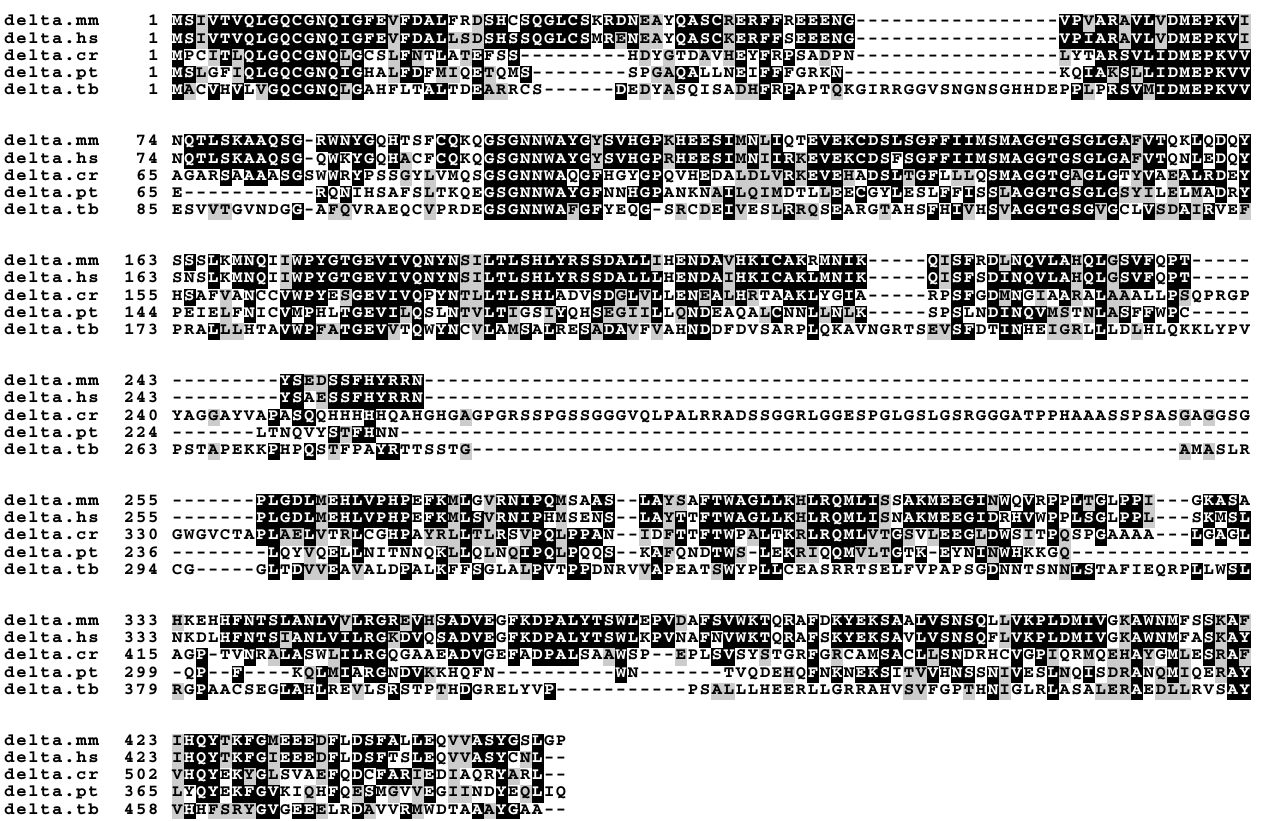
Figure 1 Comparison of the predicted δ PT1 sequence - Paramecium tetraurelia (pt) - with the the δ -tubulins from mouse (mm), man (hs), C. reinhardtii (cr) and T.brucei (tb). The aligned sequences are: H. sapiens δ -tubulin: NP07345C; M.mus- culus δ -tubulin: AF081568; C. reinhardtii δ -tubulin: AAB 71840; P. tetraurelia δ -tubulin: AJ401299; T. brucei δ -tubulin: AAF 32301. The sequences were aligned using the Clustal W1.8 program [21] and adjusted manually.